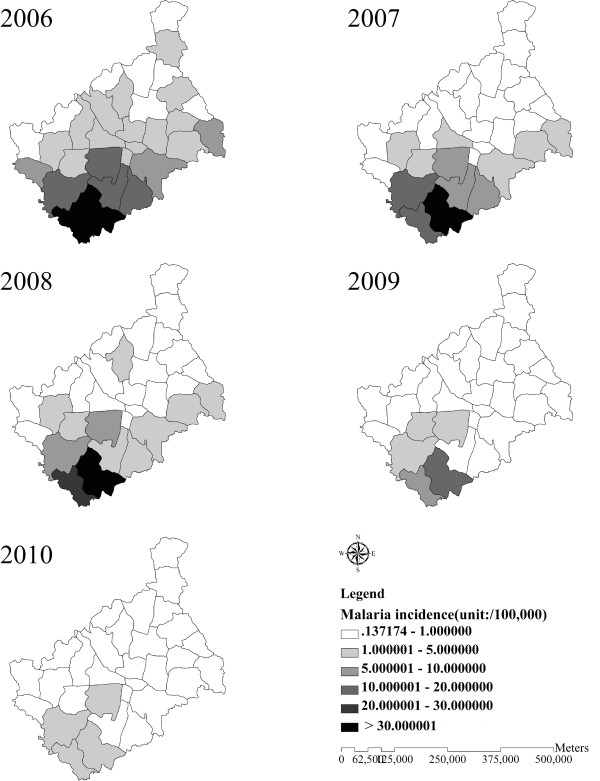
Annual malaria incidence at county level from 2006 to 2010 in Yongcheng prefecture, China. The county-lever areas are colour-coded according to annual malaria incidence, with higher malaria incidence distributed in the South of Yongcheng prefecture.